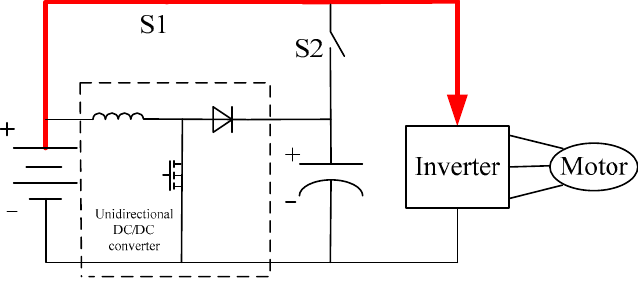
Figure 6. Mode 3—the battery acts as a unique power source.